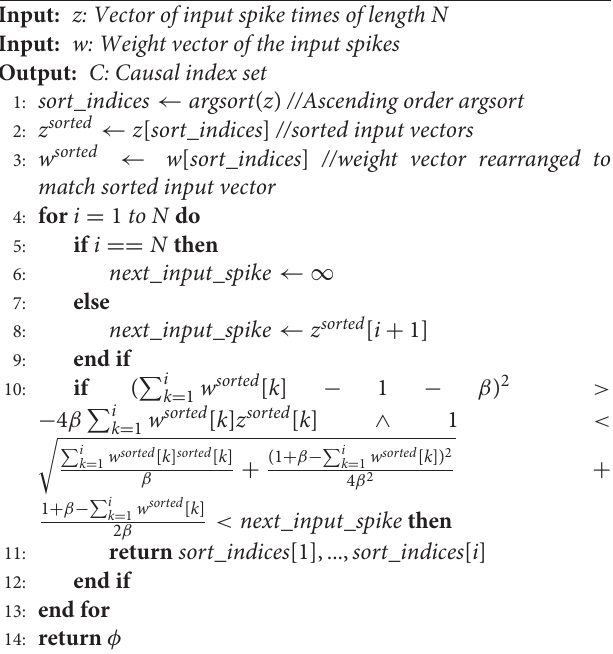
Algorithm 2 : Pseudocode of the get _ causal _ set